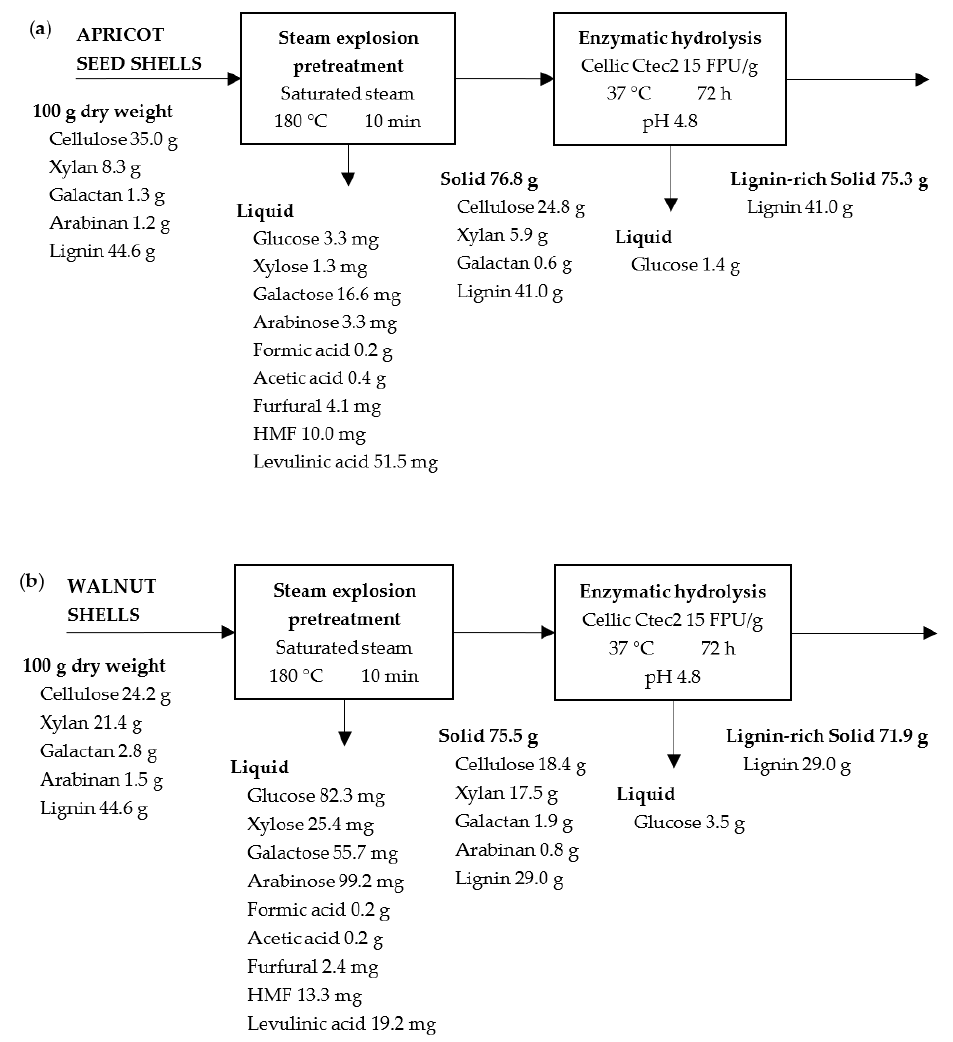
Figure 12. Mass balance for steam explosion pretreatment and enzymatic hydrolysis of apricot seed shells ( a ) and walnut shells ( b ).